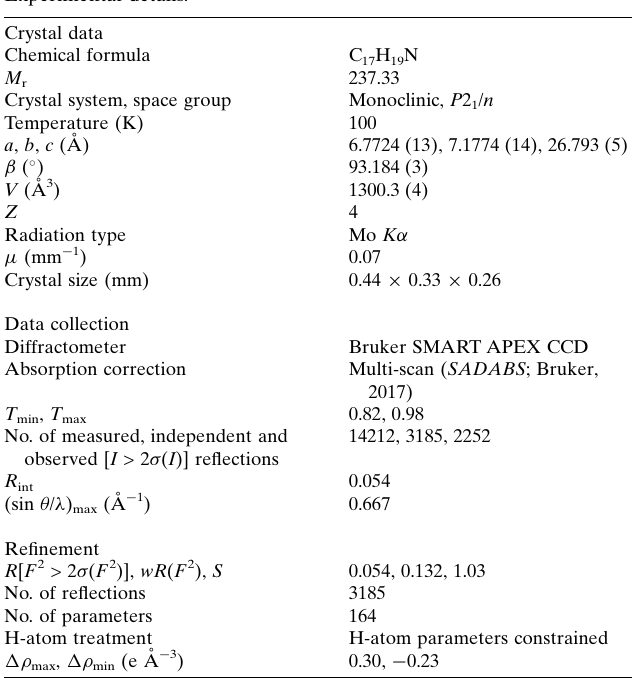
Table 2 Experimental details.